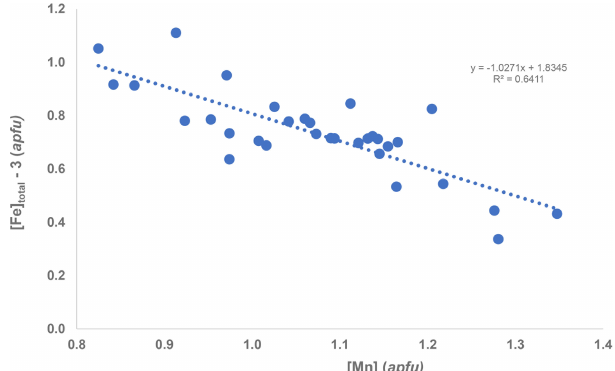
Figure 5. Plot of EMP results as atoms per formula unit (apfu) of Mn versus [Fe] total − 3 (i.e. total Fe with 3Fe atoms at M 1 + M 3 sites